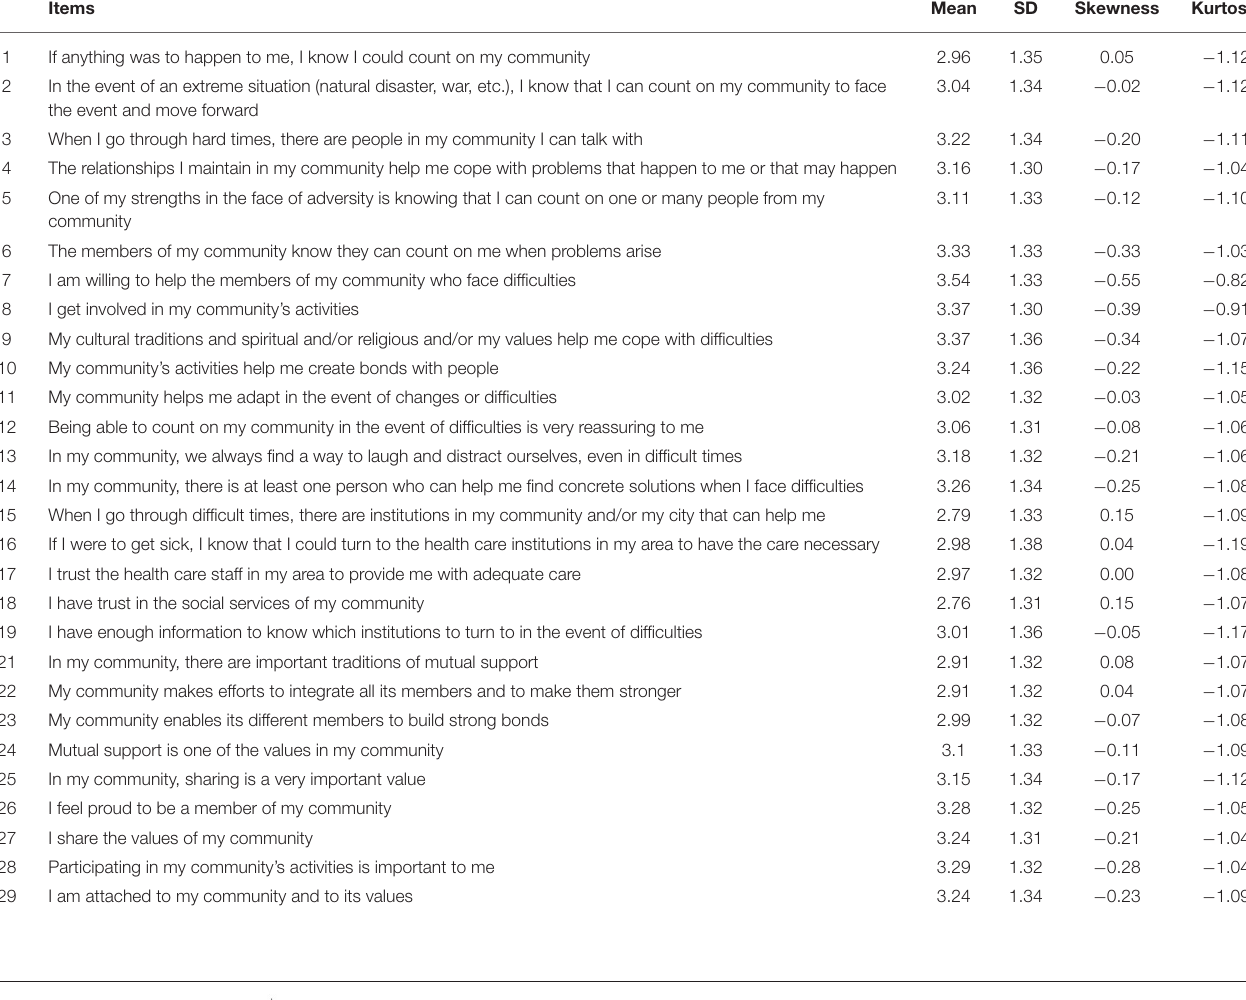
TABLE 1 | Distribution of Mean, standard deviation (SD), Skewness, and Kurtosis of the community resilience items ( N = 615; subsample 1). Items Mean SD Skewness Kurtosis